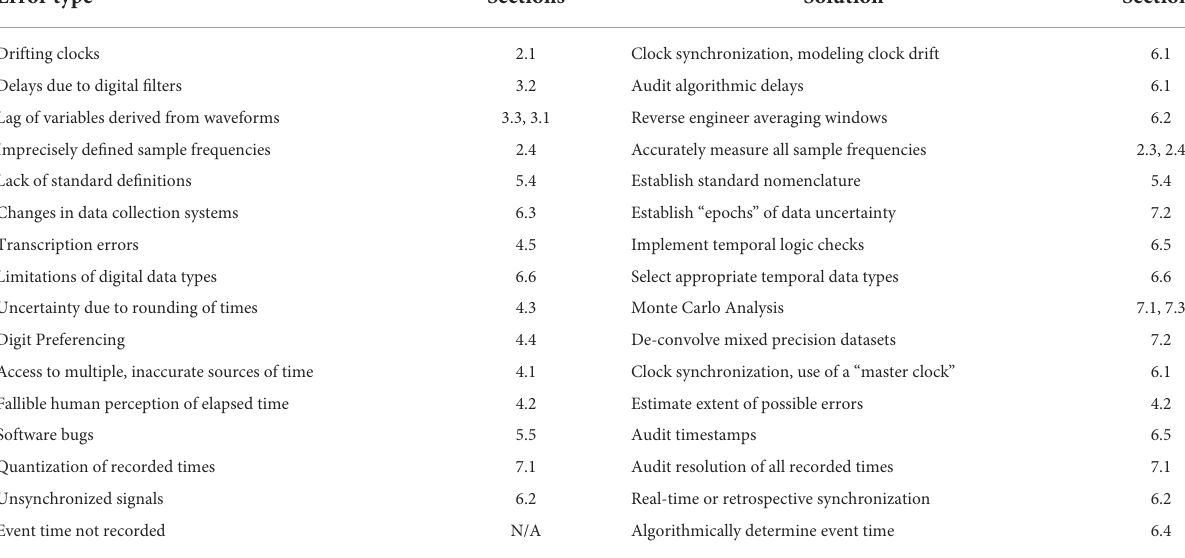
TABLE 1 Sources of timing errors and